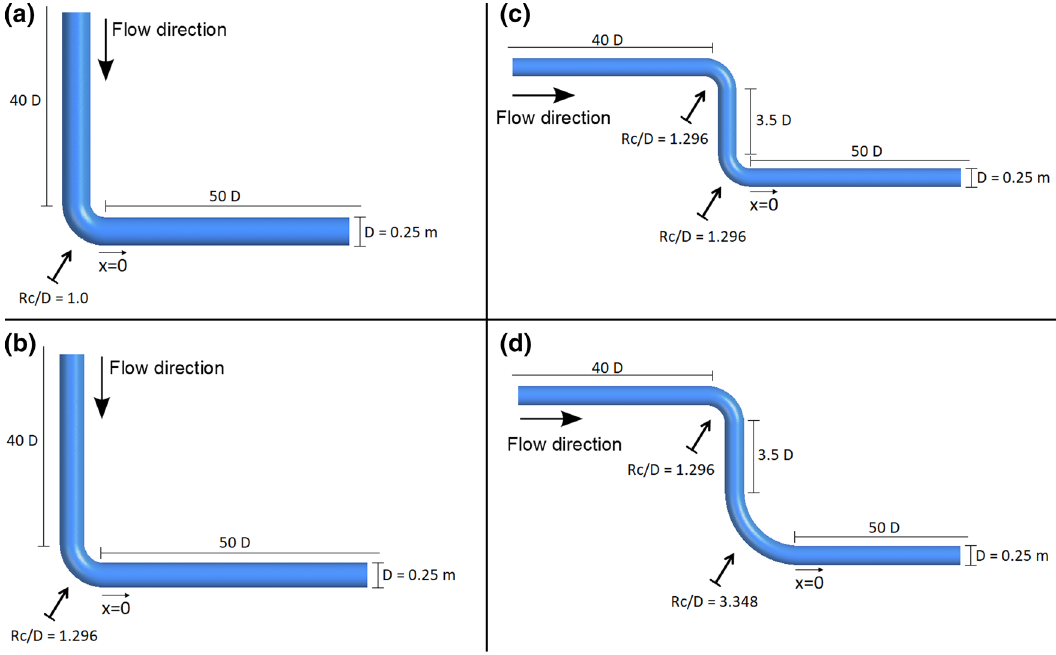
Fig. 1 Side view of the generated geometries. a Setup 1; b Setup 2; c Setup 3; d Setup